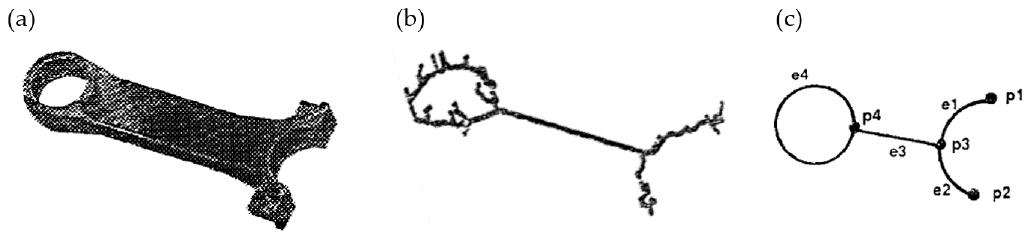
Figure 3. Skeletonization process schematic on an example of a connecting rod: ( a ) 3D model, ( b ) error skeleton spurs due to surface roughness, ( c ) idealized graph theory representation of edges “e” that are connected in vertices “p”. Reprinted from [60] with permission from Elsevier.